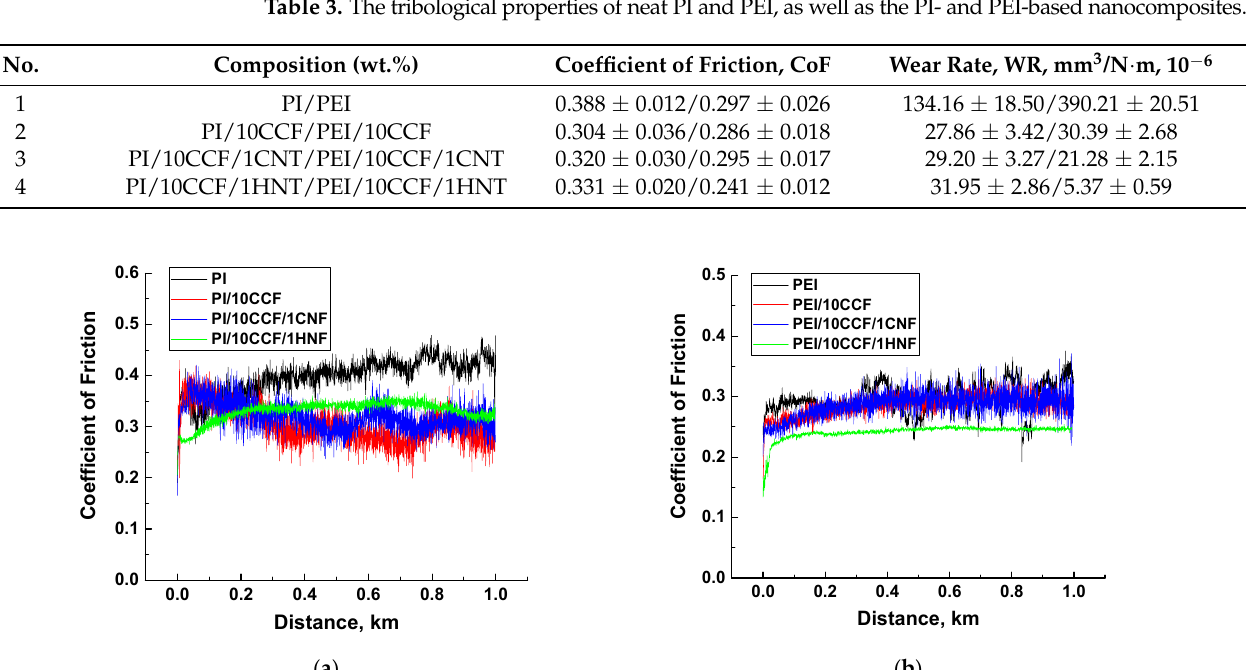
Table 3. The tribological properties of neat PI and PEI, as well as the PI- and PEI-based nanocomposites.